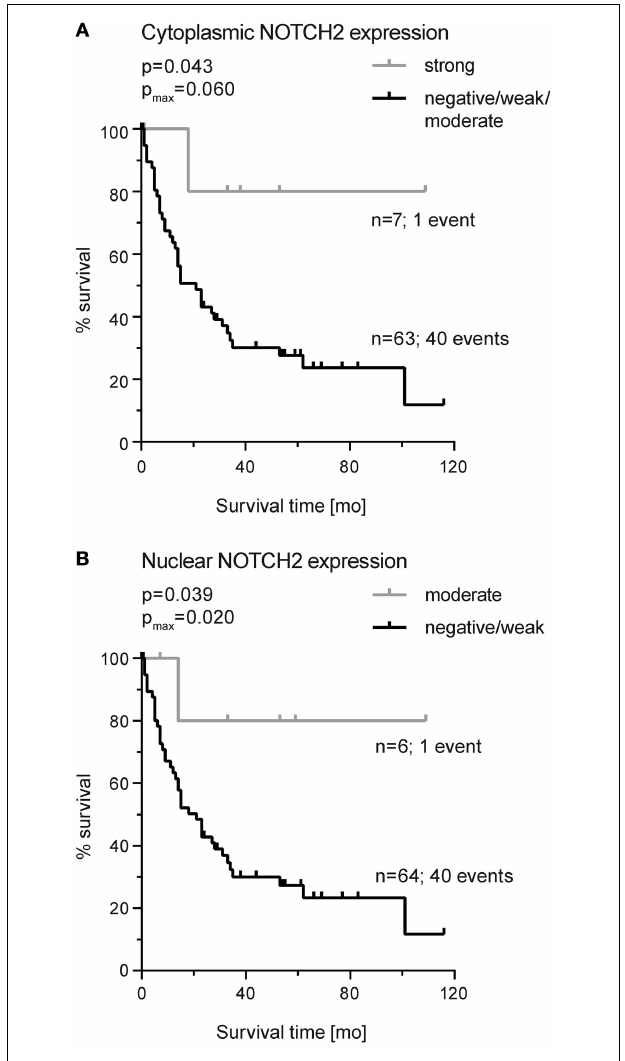
FIGURE 5 | Kaplan–Meier survival curves for NOTCH2 protein expression in primary resected gastric carcinomas of the intestinal type . (A) Cytoplasmic expression (median OS: not reached versus 21.2months; 95% CI 11.4–31.3) and (B) nuclear expression (median OS: not reached versus 21.4months; 95% CI 11.6–31.1). p -Values were determined by log-rank statistics; p max corresponds to p -value for maximally